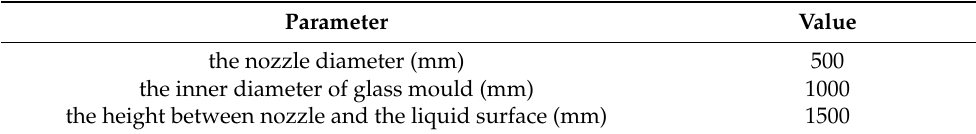
Table 3. Equipment Parameters.